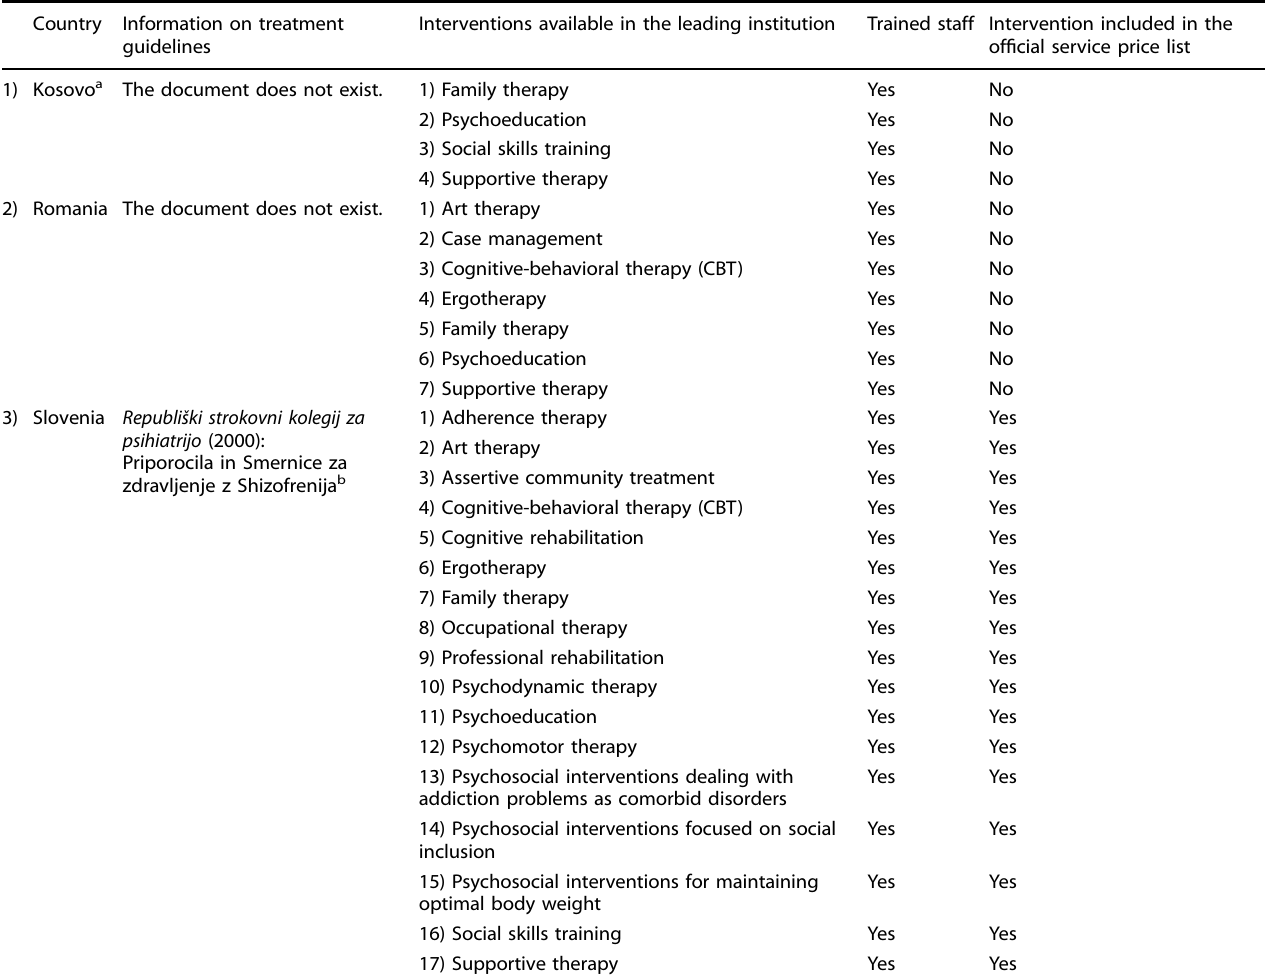
Table 2. SEE countries without published treatment guidelines for non-pharmacological treatment of schizophrenia — available interventions and implementation indicators (trained staff sand whether the intervention is included in the of fi cial service price